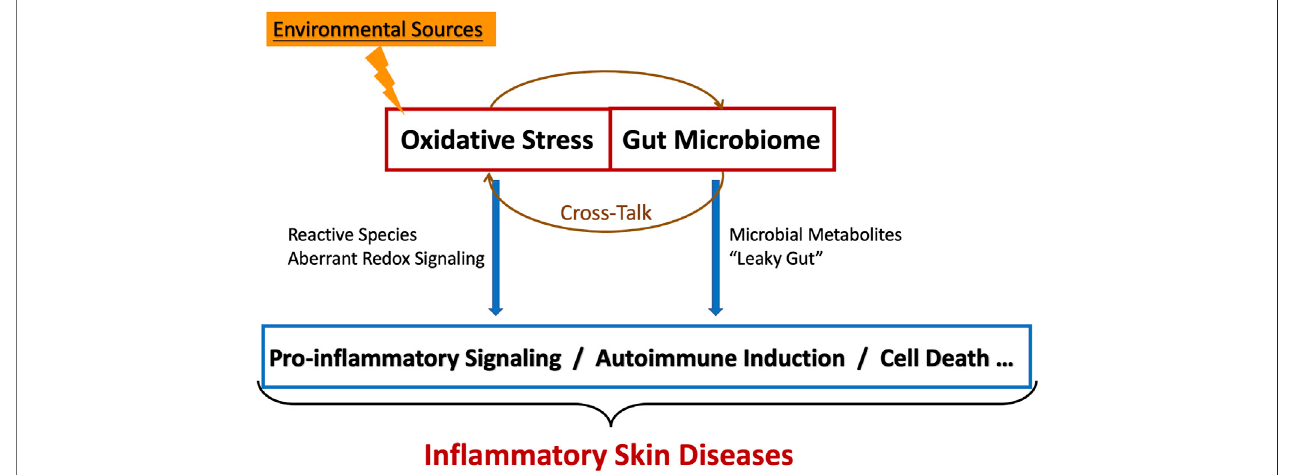
FIGURE 1 | The cross-talk between oxidative stress and gut microbiome in in fl ammatory skin diseases.